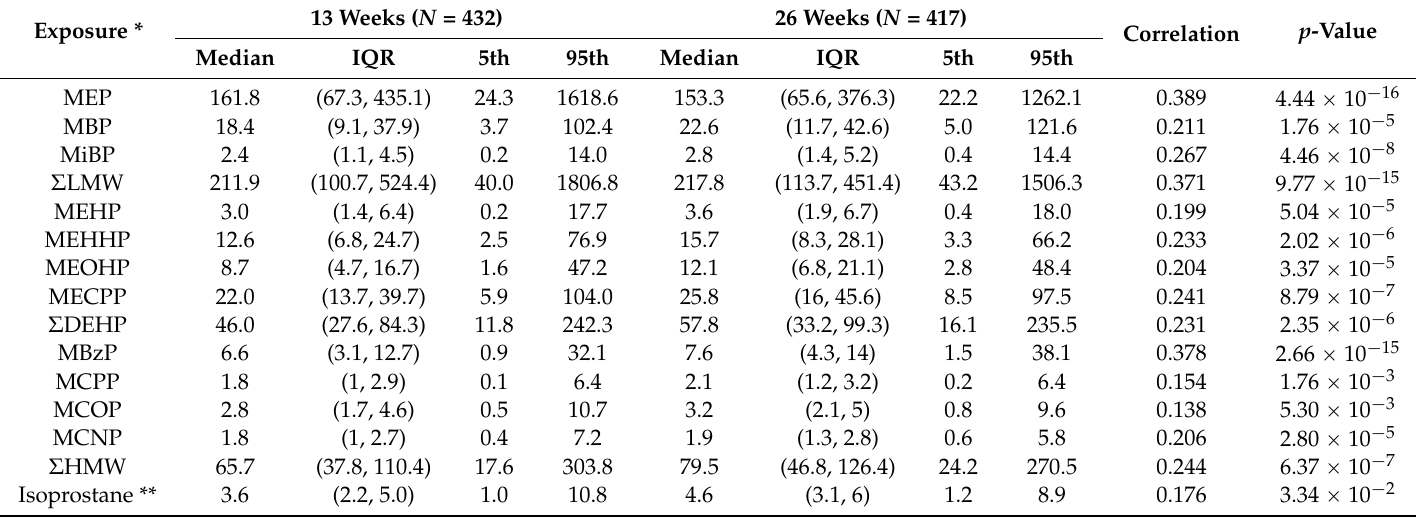
Table 2. Distribution of phthalate metabolite concentrations at 13 and 26 weeks